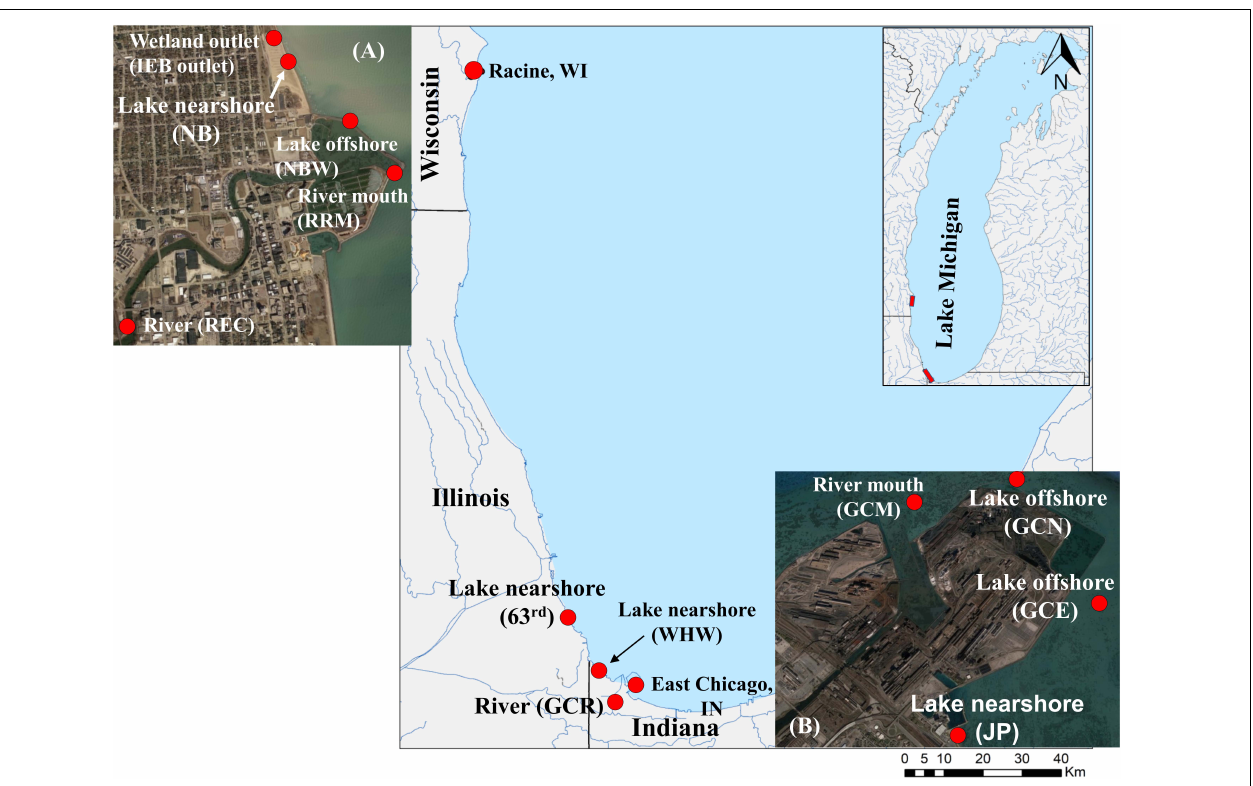
FIGURE 1 | Map of southern Lake Michigan depicting the sampling locations. Water samples were collected from river, shoreline, and offshore sites from Racine, Wisconsin; Chicago, Illinois; and East Chicago, Indiana, locations bordering southern Lake Michigan. The graphical illustration is adapted from Nevers et al. (2020). The sampling sites for river, river mouth, lake near shore, and offshore as well as wetland are shown in the enlarged insets: (A) Racine and (B) Jeorse